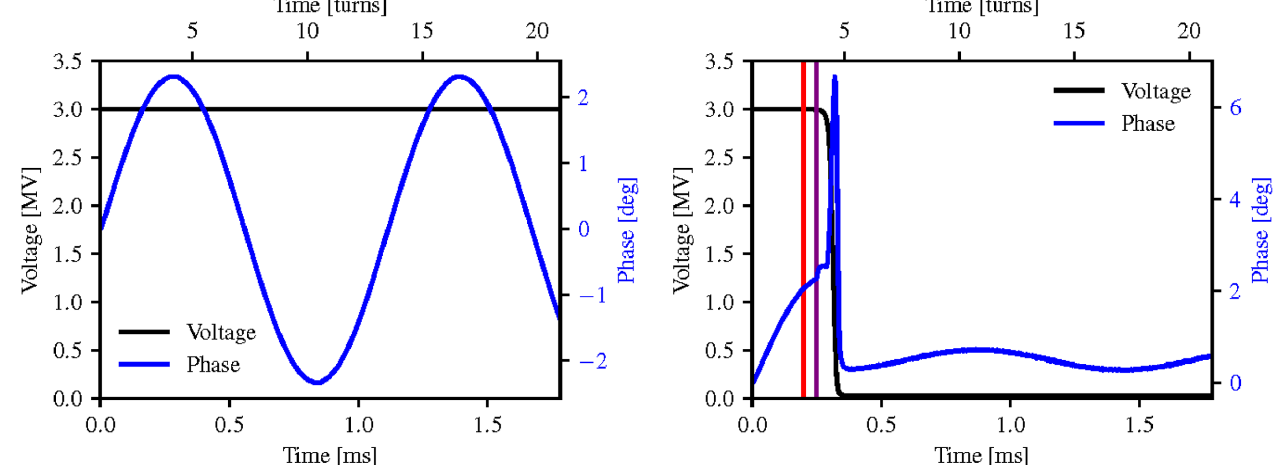
FIG. 14. Crab cavity voltage and phase as a function of time for the HL-LHC, both NoFail (left) and Fail(right) as defined in Sec. V C. For the Fail scenario, the first vertical line (red) marks the beginning of the quench, and the second line (purple) the time when pressure detuning becomes important.